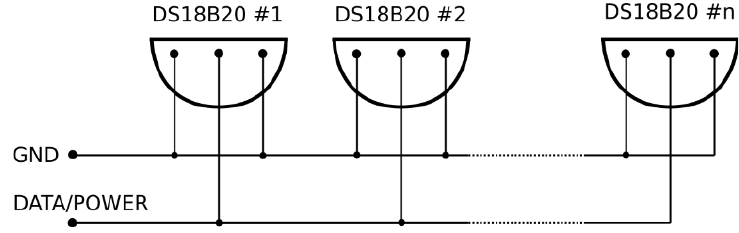
Figure 1. Parasitic connection of sensors.